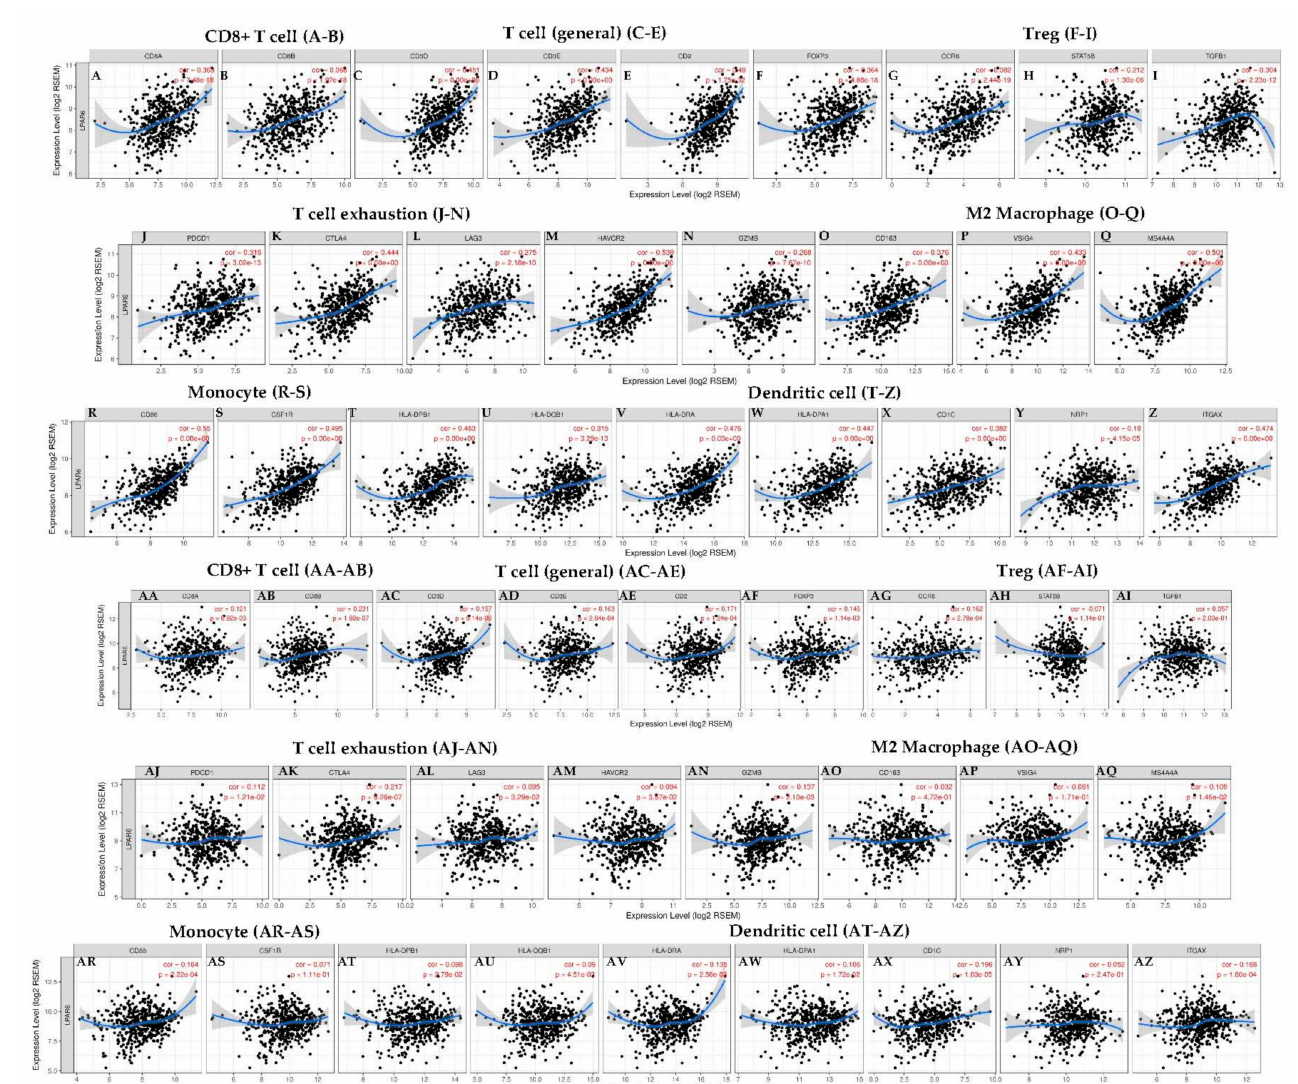
Figure 6. Correlation analysis between LPAR6 expression and immune marker sets in LUAD and LUSC. Markers include CD8A and CD8B of CD8+ T cell; CD3D, CD3E and CD2 of general T cell; FOXP3, CCR8, STAT5B and TGFB1 of Treg; PDCD1, CTLA4, LAG3, HAVCR2 and GZMB of exhausted T cells; CD163, VSIG4 and MS4A4A of M2 macrophages; CD86 and CSF1R of monocytes; HLA-DPB1, HLA-DQB1, HLA-DRA, HLA-DPA1, CD1C, NRP1 and ITGAX of Dendritic cell. ( A – Z ) Scatterplots of correlations between LPAR6 expression and gene markers of CD8+ T cell ( A , B ), general T cell ( C – E ), Treg ( F – I ), T cell exhaustion ( J – N ), M2 macrophage ( O – Q ), monocyte ( R – S ) and dendritic cell ( T – Z ) in LUAD. ( AA – AZ ) Scatterplots of correlations between LPAR6 expression and gene markers of CD8+ T cell ( AA , AB ), general T cell ( AC – AE ), Treg ( AF – AI ), T cell exhaustion ( AJ – AN ), M2 macrophage ( AO – AQ ), monocyte ( AR – AS ) and dendritic cell ( AT – AZ ) in